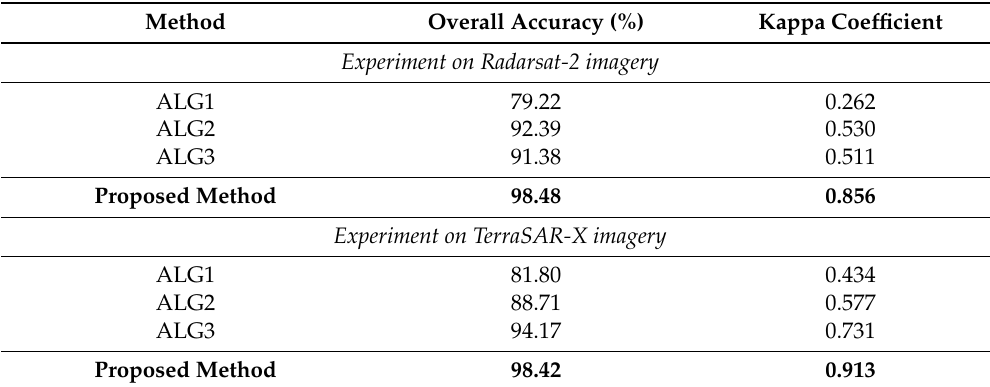
Table 2. Overall Accuracy and Kappa Coefficient Comparison.